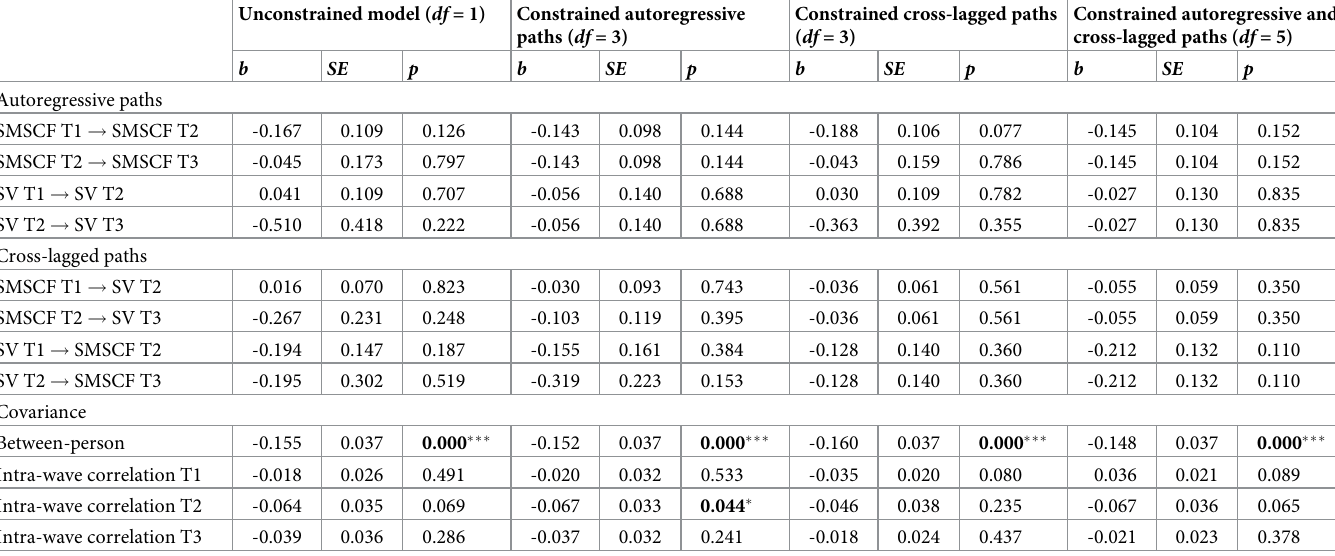
Table 7. Reciprocal relationships between social media self-control failure and subjective